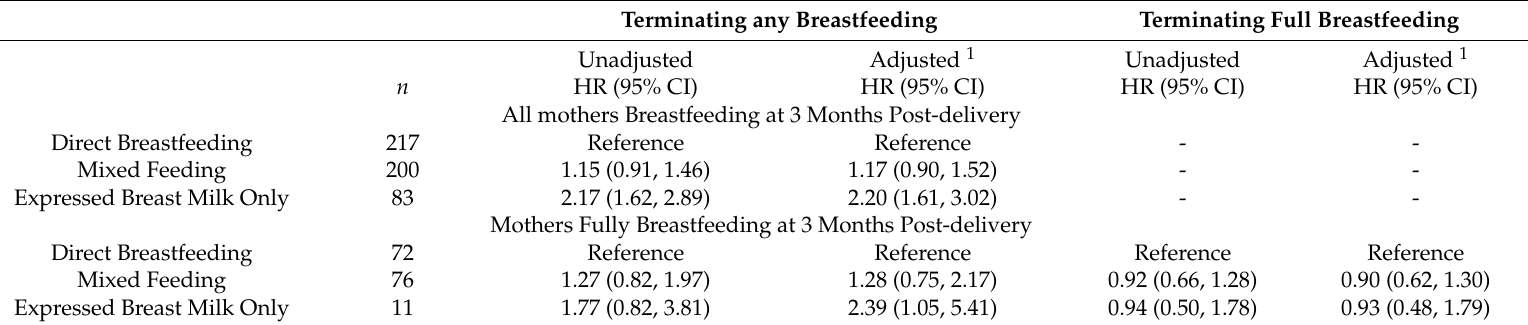
Table 3. Associations of the mode of breastfeeding at 3 months post-delivery on the risk of terminating any and full